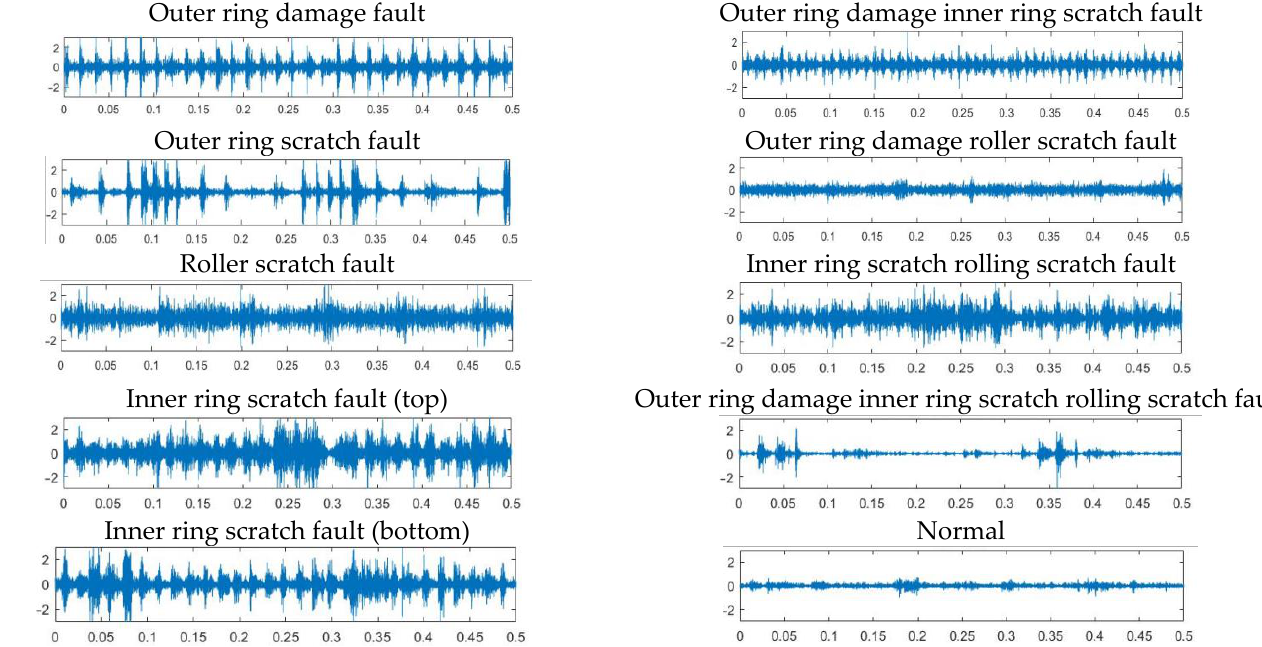
Figure 15. Time domain waveforms of bearing vibration signals for 10 states.